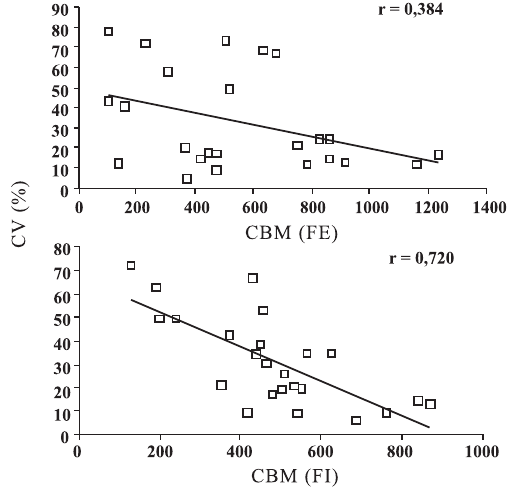
Figura 1. Correlação entre o coeficiente de variação (CV) e o carbono da biomassa microbiana (CBM) obtidos pelos métodos de (a) fumigação– incubação (F1) e (b) fumigação–extração (FE).